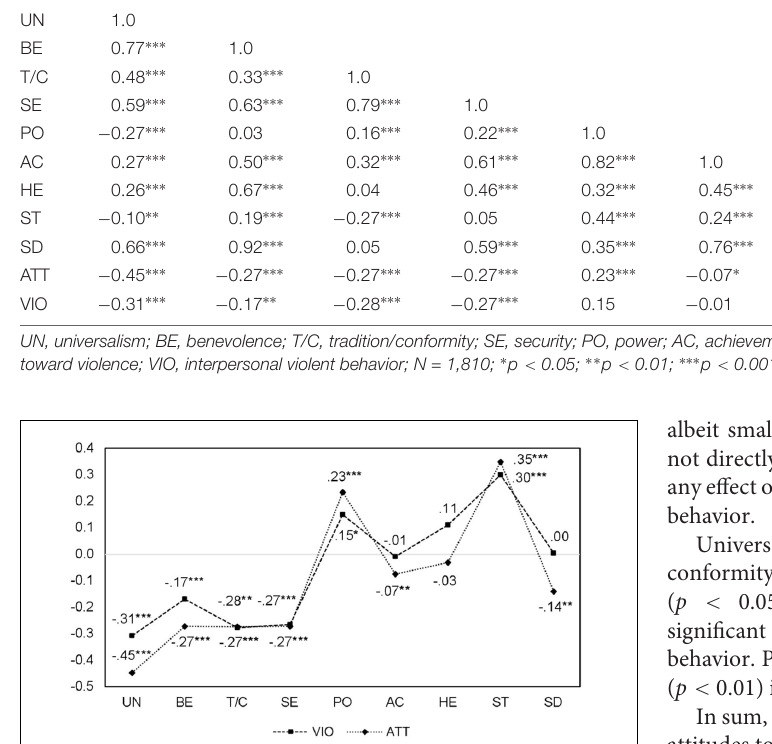
FIGURE 3 | Correlations between values, attitudes toward interpersonal violence, and interpersonal violent behavior. UN, universalism; BE, benevolence; T/C, tradition/conformity; SE, security; PO, power; AC, achievement; HE, hedonism; ST, stimulation; SD, self-direction; ATT, attitudes